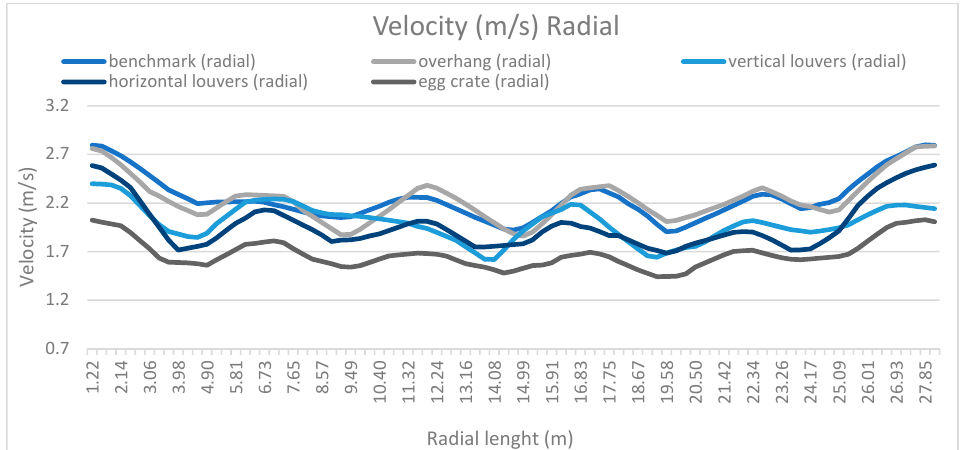
Figure 9. Velocity profile for Axial direction (CFD).